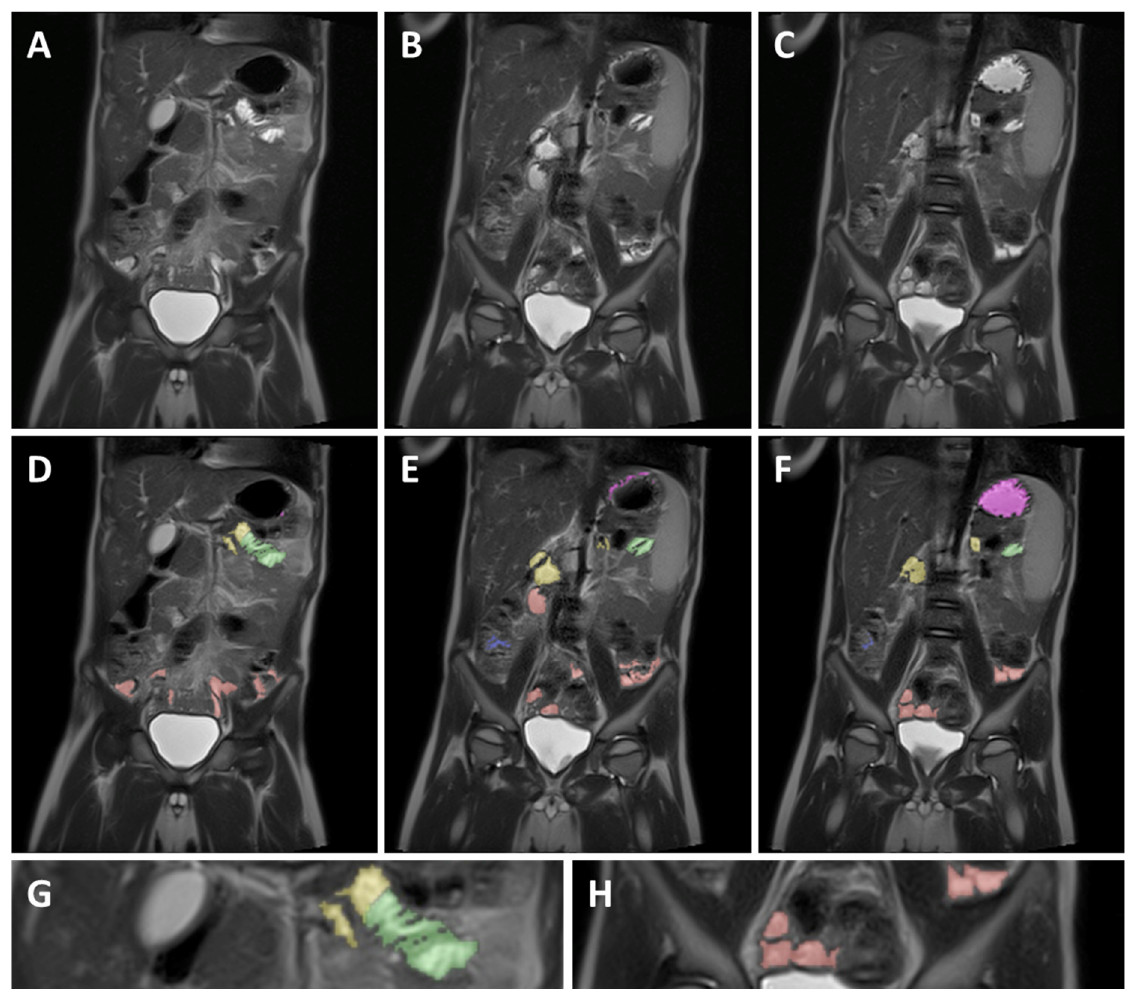
Figure 2. Example of MRI identification of fluid pockets in different GI segments on 3 coronal T2 weighted spin echo images of a 5-year-old child. ( A – C ) are unmarked images; ( D – F ) are the corresponding marked images. Purple marked areas are located in the stomach, yellow in the duodenum, green in the jejunum, red in the ileum, and blue in the colon. ( G ) is a detailed view of the jejunum (green), showing the circular folds as the typical striped pattern in the fluid pocket. ( H ) is a detailed view of the ileum marked in red, showing the smooth intestinal wall.